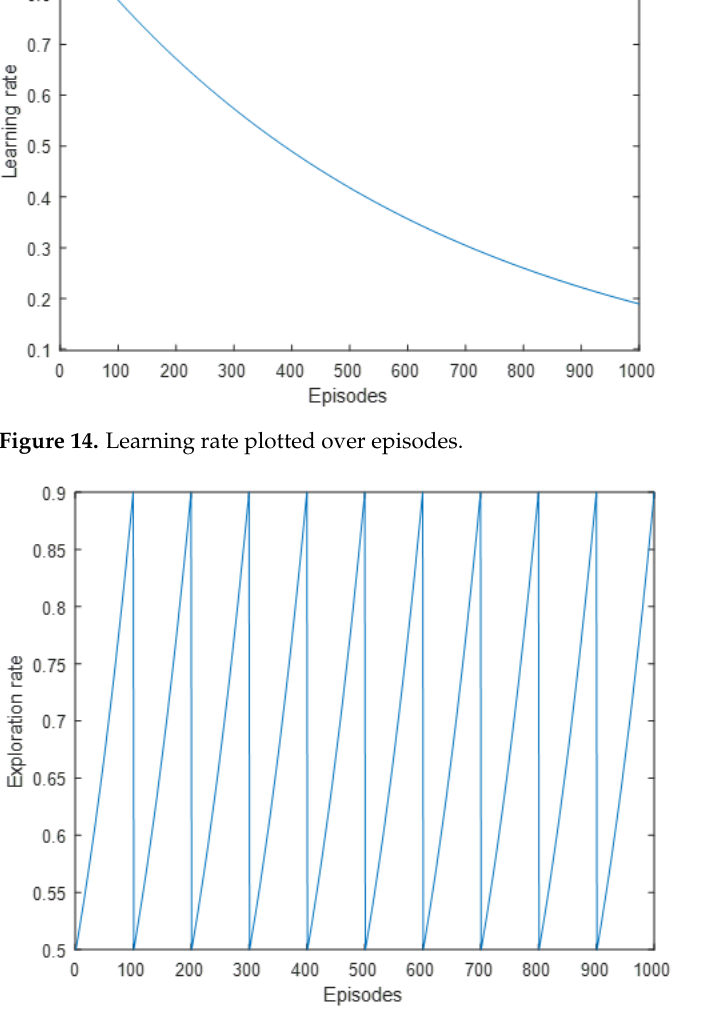
Figure 15. Exploration rate plotted over episodes.